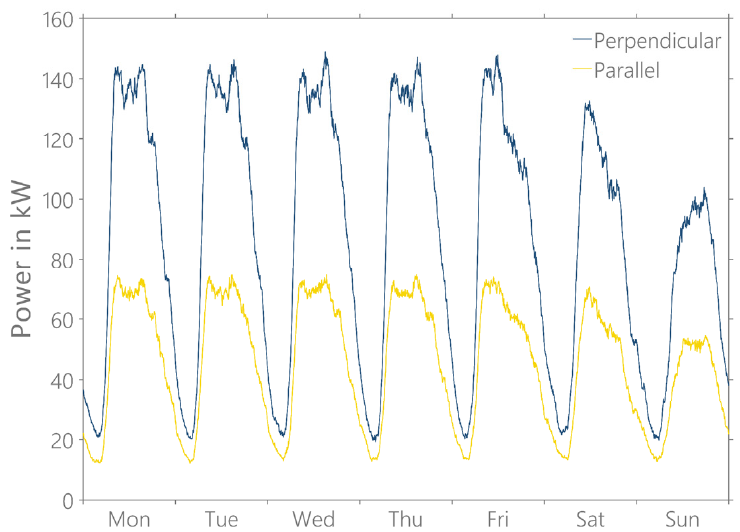
Figure 18. Maximum power of public CPs over the course of a week with an “electric avenue” in perpendicular and parallel arrangement.